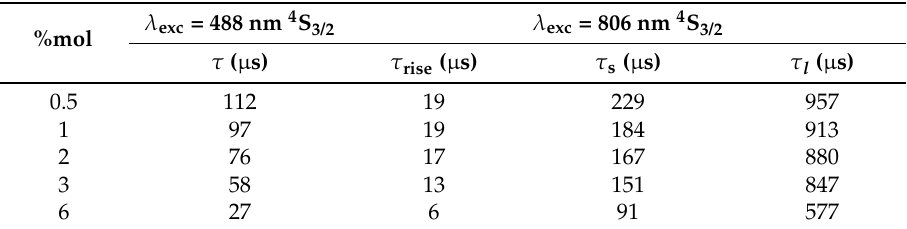
Figure 5. Semilogarithmic plot of the experimental decays of the ( a ) green emission from the 4 S 3/2 level and ( b ) red emission from the 4 F 9/2 level obtained under excitation at 488 nm and 806 nm. Table 2. Lifetime values of the 4 S 3/2 level obtained under excitation at 488 nm and 806 nm.